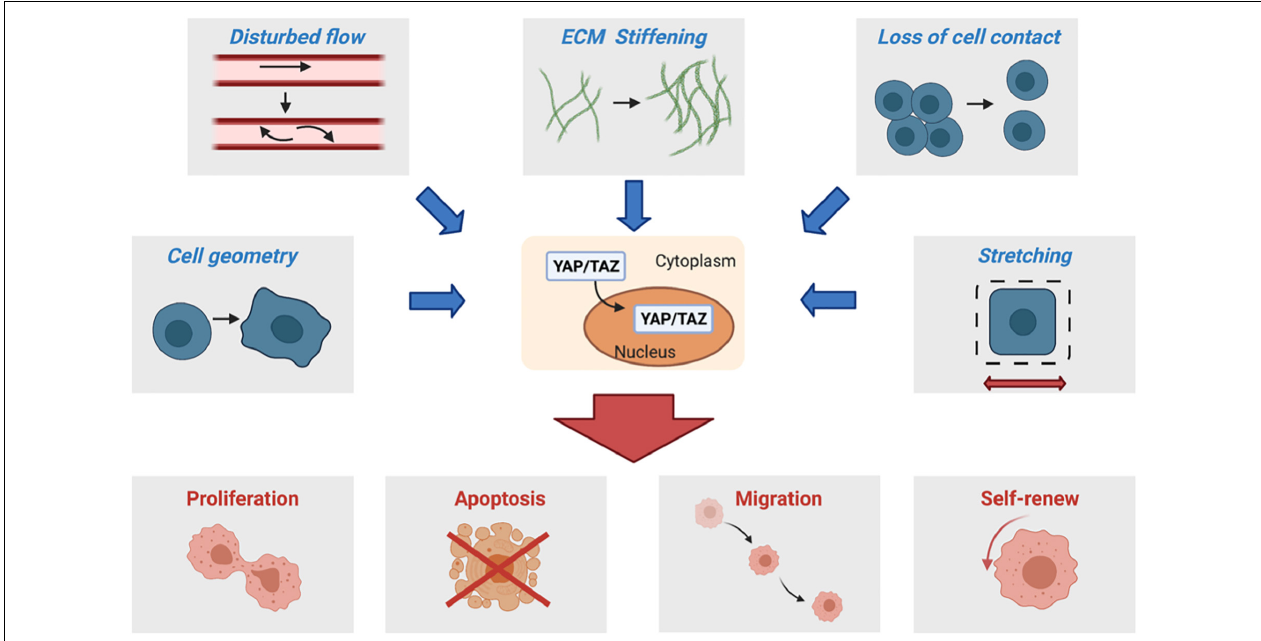
FIGURE 1 | Changes in the biophysical environments, such as those resulting from ECM stiffening, loss of cell contact, disturbed flow, cell spreading, and stretching, promote nuclear translocation of YAP/TAZ and thus activate their transcription programs for cell proliferation, survival, migration, and self-renew, among